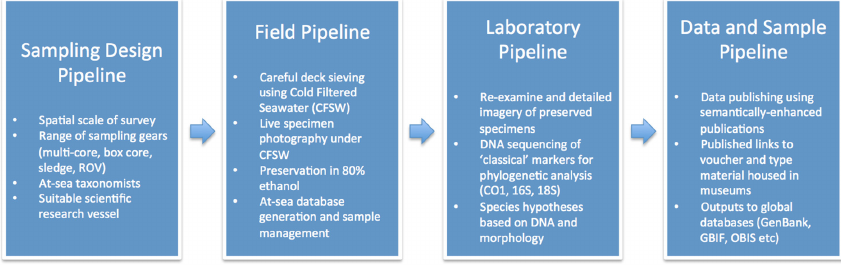
Figure 5. We present a methodological pipeline for DNA taxonomy in the Clarion Clipperton Zone that incorporates and end-to-end management approach from the sampling design, field program, laboratory studies and data and sample archiving. This is designed to allow researchers and contractors working in the region to work collaboratively to gradually build a modern taxonomic synthesis of the region, upon which environmental impact assessments can be built in the future.